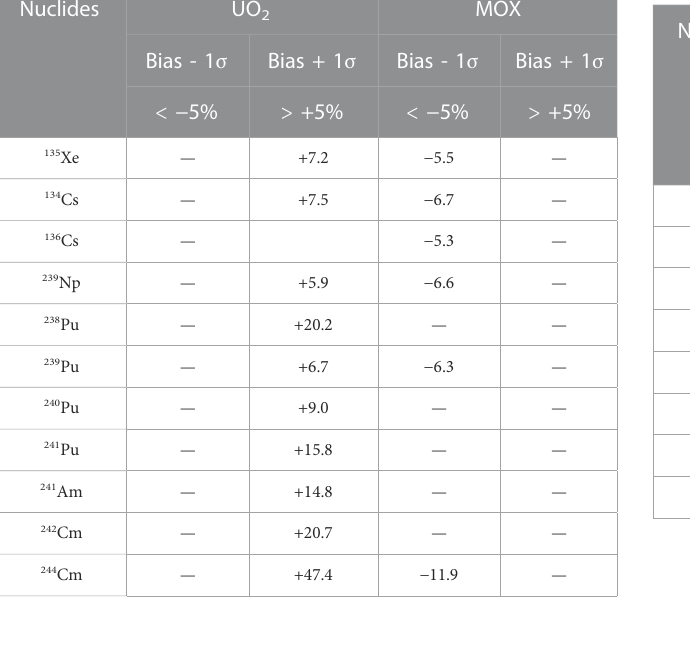
TABLE 7 Maximum signi fi cant bias ( | bias | > 2 %) due to ILA for UO 2 and MOX fuel